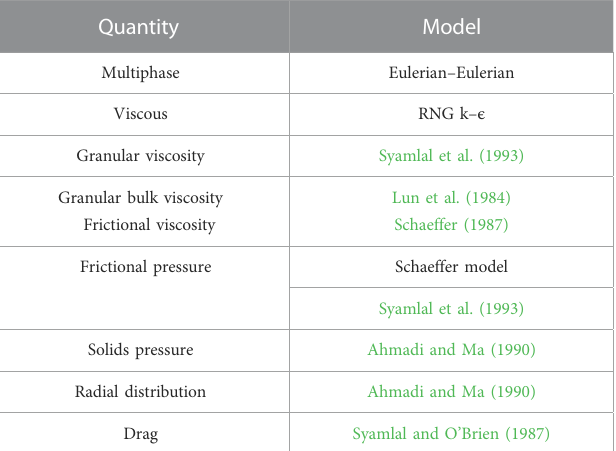
TABLE 2 Models used for different quantities.